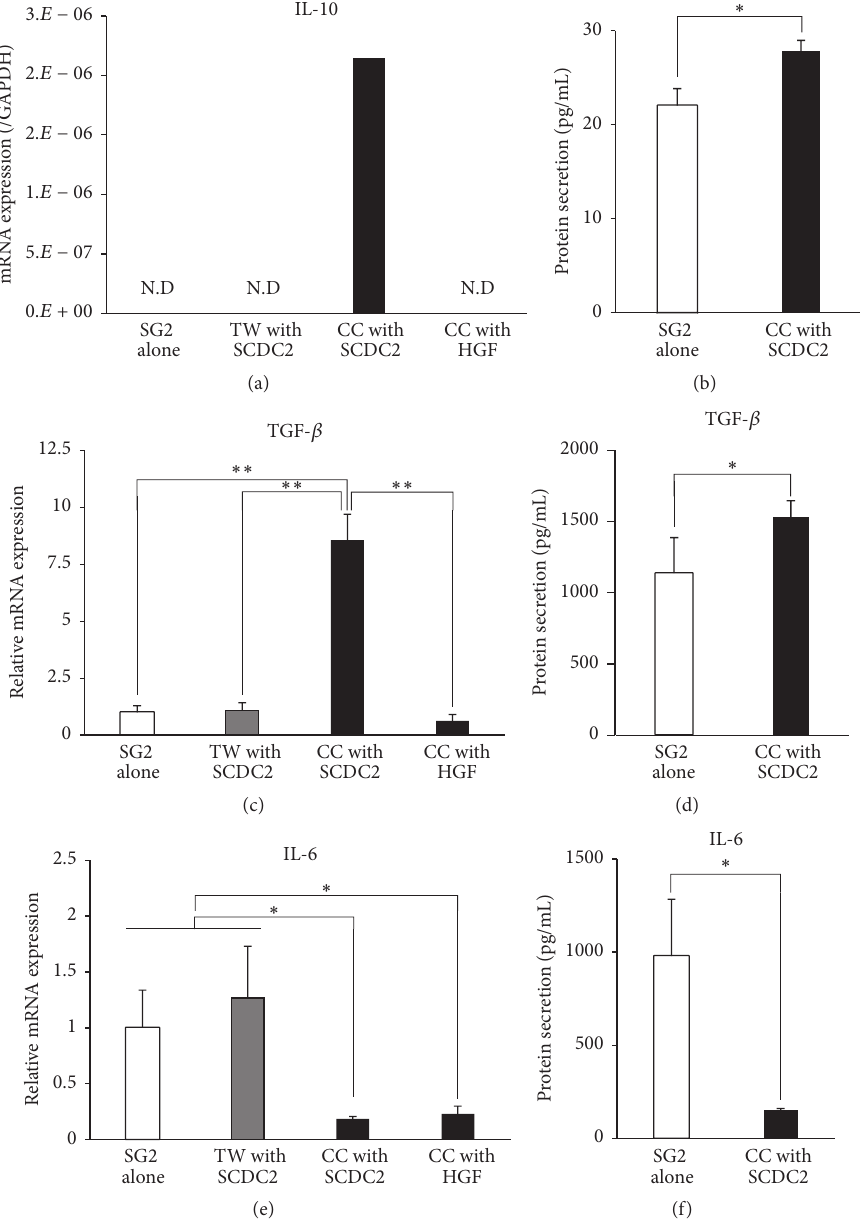
Figure 3: Expression levels of the anti-inflammatory cytokines IL-10 and TGF- 𝛽 in SG2 cells increased by direct-contact coculture between SG2 and SCDC2 cells, whereas IL-6 expression decreased. SG2 cells were cocultured with SCDC2 cells or HGFs in a direct (CC) coculture system and an indirect transwell (TW) coculture system. (a, c, e) mRNA expression levels were investigated by RT-qPCR using rat-specific primers. Reported values are normalized to Gapdh expression. The results are expressed as the fold change relative to the respective control (SG2 alone). (b, d, f) Cytokines produced from the SG2 cells were quantified using sandwich ELISA with mouse-specific antibodies that show no cross-reactivity with those of rats. Quantified target proteins are presented as the mean ± standard deviations. ∗ 𝑃 < 0.05 , ∗∗ 𝑃 < 0.01